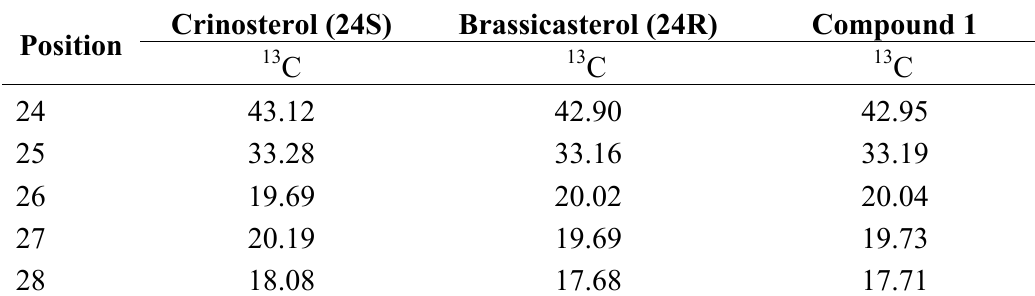
Table 2. Partial 13 C-NMR spectral data of the model compounds (crinosterol and brassicasterol) and 1